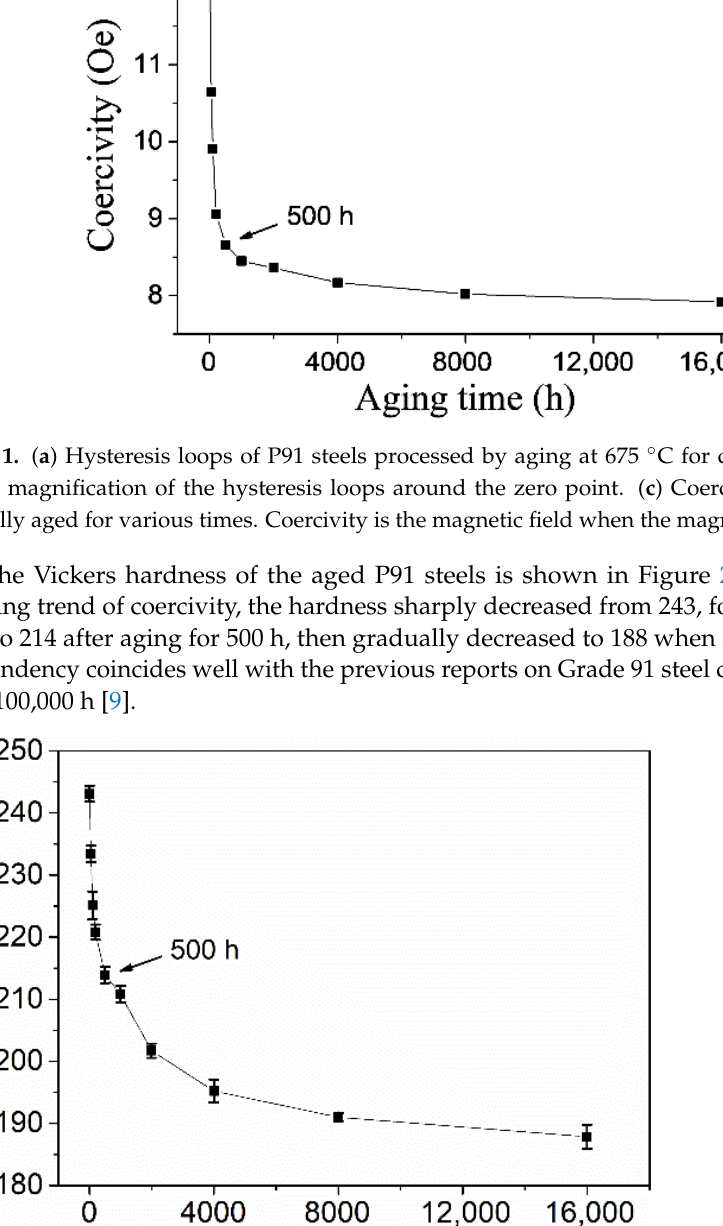
Figure 2. Vickers hardness of the present steels with varying aging times. The error bar represents the 95% confidence interval of the measurements.